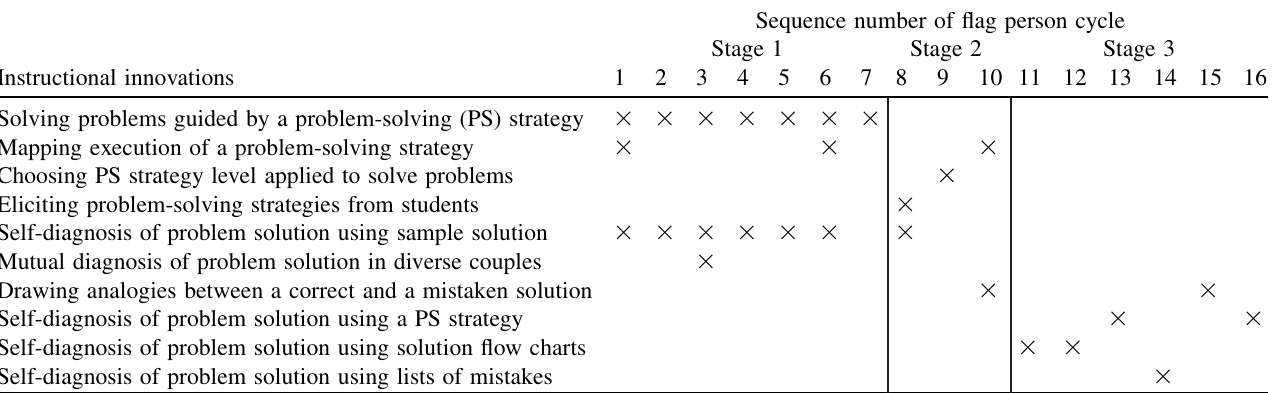
TABLE V. Workshop C (cognitive apprenticeship): Implemented